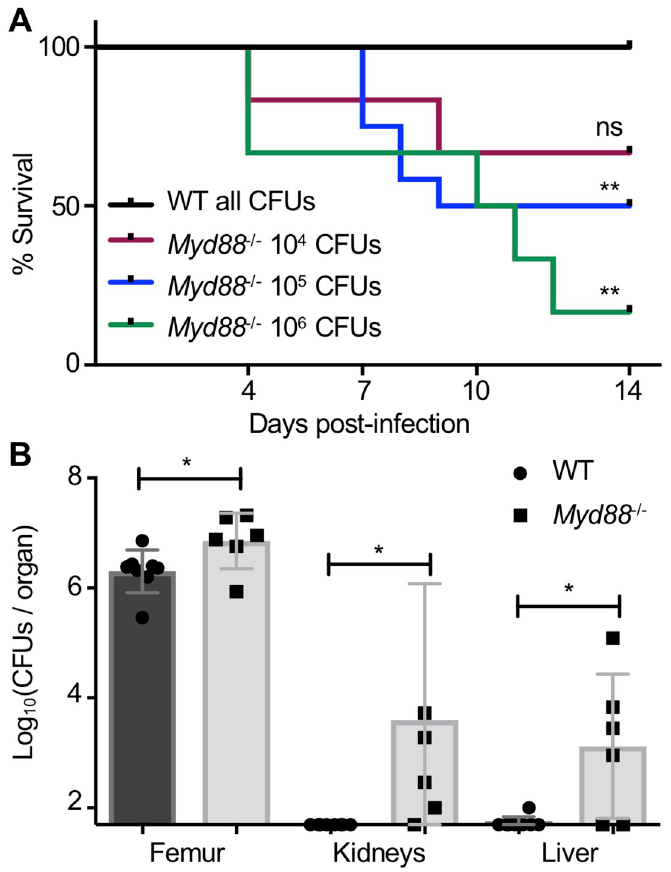
Fig 3. The innate immune signaling adapter MyD88 is critical for the control of bacterial burdens and systemic dissemination during S. aureus osteomyelitis. (A-B) Osteomyelitis was established in female WT and Myd88 -/- mice, following infection with varying S. aureus inocula: 10 6 CFUs (WT n = 5, Myd88 -/- = 6), 10 5 CFUs (WT n = 10, Myd88 -/- = 12; duplicate experiments), 10 4 CFUs (WT n = 6, Myd88 -/- = 6). Bacterial burdens were quantified from the infected femur, as well as both kidneys and the liver as a measure of bacterial dissemination. (A) Over the 14-day course of infection, mice were monitored for humane endpoints, and if necessary, mice were euthanized, and mortality was recorded. Log-rank Mantel Cox test was used to compare WT and Myd88 -/- survival curves due to infection mortality for each S. aureus inoculum. �� p < 0.01, ns = not significant. (B) Bacterial burdens were enumerated in surviving mice at day 14 post-infection in duplicate experiments, following inoculation with 10 5 S. aureus CFUs (WT n = 8, Myd88 -/- n = 6; duplicate experiments). Symbols represent individual data points from each mouse (WT = circles; Myd88 -/- = squares), the top line of each bar represents the mean, and error bars represent standard deviation. Unpaired t -tests were used to compare CFU burdens between WT and Myd88 -/- organ homogenates. � p < 0.05, ns = not significant. In the absence of MyD88 signaling, mice are unable to control S . aureus infection, indicat- ing that upstream receptors that signal through MyD88, including S . aureus -recognizing TLRs and IL-1R, may be important for antibacterial protection. The high levels of IL-1 and IL-1-reg- ulated cytokines present in S . aureus infected femurs led us to investigate the contribution of IL-1R signaling to anti-staphylococcal immunity in bone. We subjected WT and Il1r1 -/- mice to S . aureus osteomyelitis. In contrast to the extreme systemic morbidity observed in MyD88 -/- mice suffering from osteomyelitis, Il1r1 -/- mice had less morbidity when compared to WT mice, in that they lost significantly less weight over the course of infection (Fig 4A). To deter- mine the role of IL-1R and the relative contributions of IL-1 isoforms (IL-1 α or IL-1 β ) to con- trol bacterial burdens in bone, WT, Il1r1 -/- , Il1a -/- , and Il1b -/- mice were subjected to S . aureus